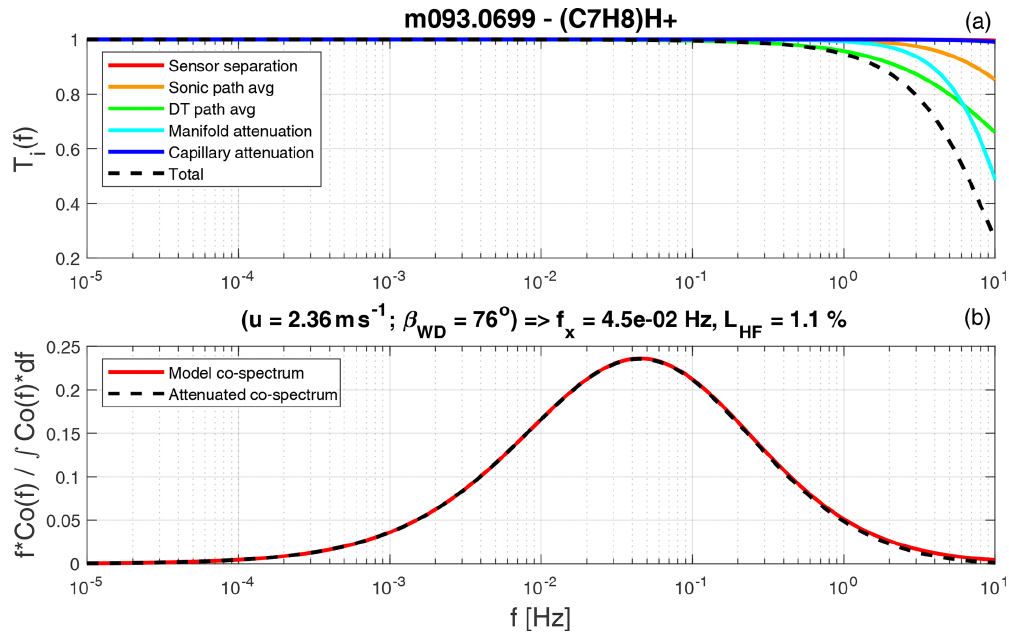
Figure 7. Spectral analysis for toluene for the averaging period 11:30–12:00UTC, 27 July 2015. Panel (a) shows individual transfer functions in color (see Sect. S4 in the Supplement for details) and the transfer function of the total high-frequency attenuation. Panel (b) shows the model co-spectrum (red) and the attenuated co-spectrum